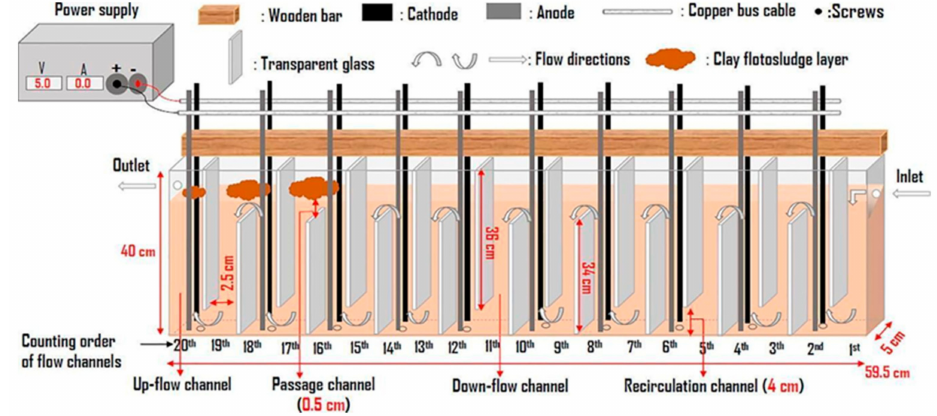
Figure 17. Configuration of a recent continuous flow reactor design